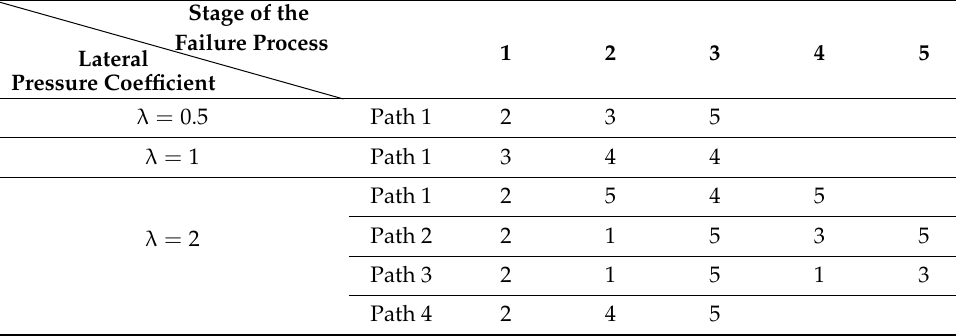
Table 9. The level of impact on the structure.